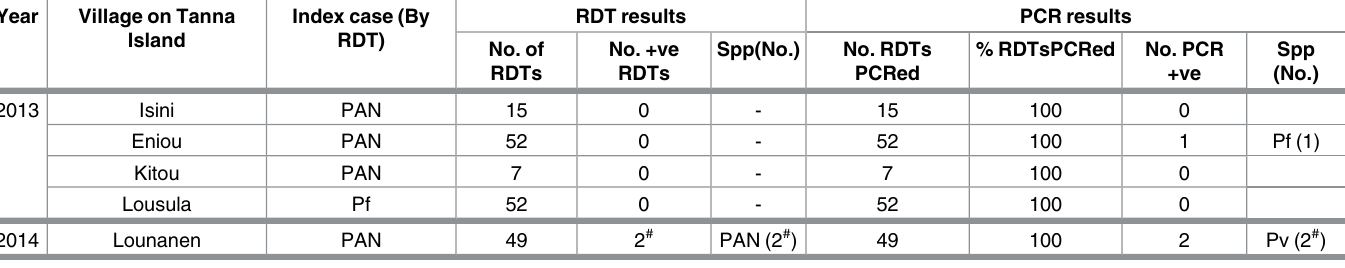
Table 3. Time, location, number of individuals tested and results of RDT and PCR from used-RDTs in Re-ACDsconducted on Tanna Island, Tafea Province. Year Village on Tanna